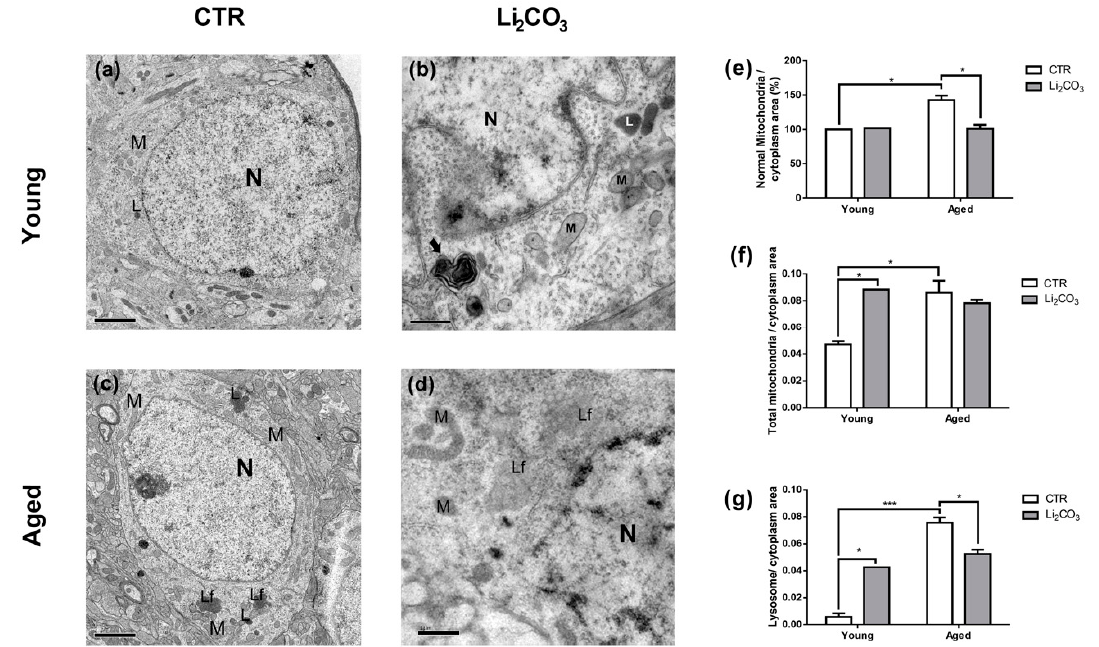
Figure 3. Lithium alters the morphology of organelles in the striatum of aged rats. Representative electron micrographs of dorsolateral striatal neurons from young and aged control animals ( a ) and ( c ), respectively) or Li 2 CO 3 treated (4.7 mM, 30 days) young and aged animals ( b ) and ( d ), respectively). In ( a , c ), representative striatal neurons displaying diverse organelles with normal appearances, like mitochondria (M), lysosome (L), telolysosome (lipofuscin granule, Lf) and nucleus (N). In ( b ), a striatal neuron of a Li 2 CO 3 -treated young animal showing the normal ultrastructural appearance of all organelles like mitochondria (M), heterolysosome (L), and nucleus (N) and the presence of an autophagic vacuole (arrow). In ( d ), a striatal neuron of a Li 2 CO 3 -treated aged animal revealing some telolysosome (lipofuscin granule, Lf) and electrondense mitochondria with swollen cristae (M). Scale bars represent 2 µ m in ( a ) and ( b ); 1 µ m in ( c ) and ( d ). Micrographs digitally obtained (Orius GATAN, USA) through a transmission electron microscope at 80 kV (JEOL1200 EXII, Japan). Histograms showing normal ( e ) and total ( f ) mitochondria area, and lysosomes ( g ) in relation to the cytoplasm area. In ( e ) the values are presented as a percentage of the control. All histograms are a mean ± SEM ( n = 2). * p < 0.05 and *** p < 0.001 (two-way ANOVA, Bonferroni